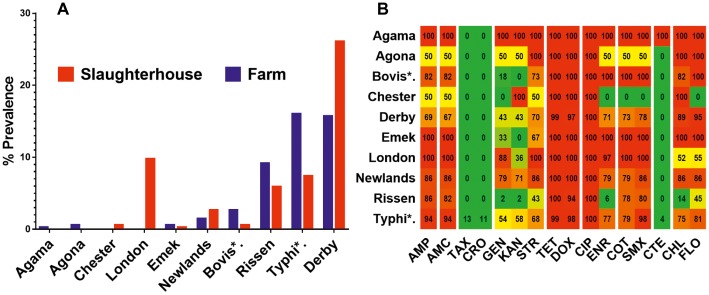
The serovar and antibiotic resistance diversity of Salmonella across farm and slaughterhouse. (A) Spatial variation of the distribution of multiple salmonellae serovars isolated from fecal samples analyzed in this study. (B) Distribution of the average resistance (in percent) of various serovars (YY′) irrespective of the source of isolation toward multiple antibiotics (XX′). The color scale of the individual cells is quantified by the numerical values in the heat map to indicate the resistance percentage. Abbreviated names of the serovars are Bovis*: Bovismorbificans and Typhi*: Typhimurium. The names of the antibiotics (XX′) are abbreviated as ampicillin (AMP), amoxicillin (AMC), cefotaxime (TAX), ceftriaxone (CRO), gentamicin (GEN), kanamycin (KAN), streptomycin (STR), tetracycline (TET), doxycycline (DOX), ciprofloxacin (CIP), enrofloxacin (ENR), sulfa-trimethoprim (COT), sulfamethoxazole (SMX), colistin (CTE), chloramphenicol (CHL), and florfenicol (FLO).